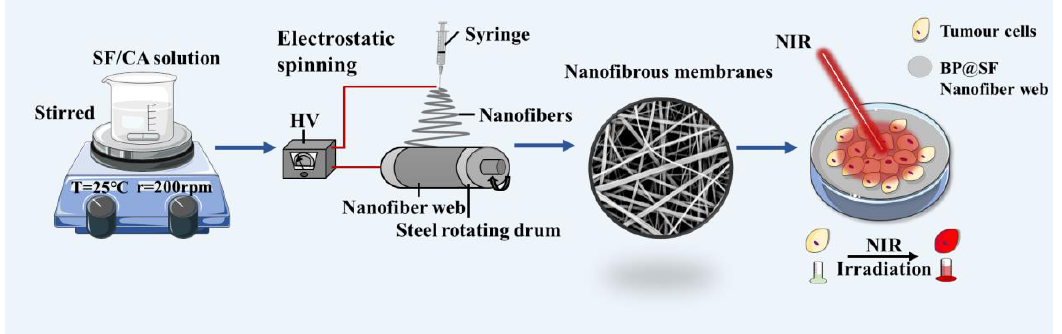
Figure 7. Schematic diagram of sample preparation.